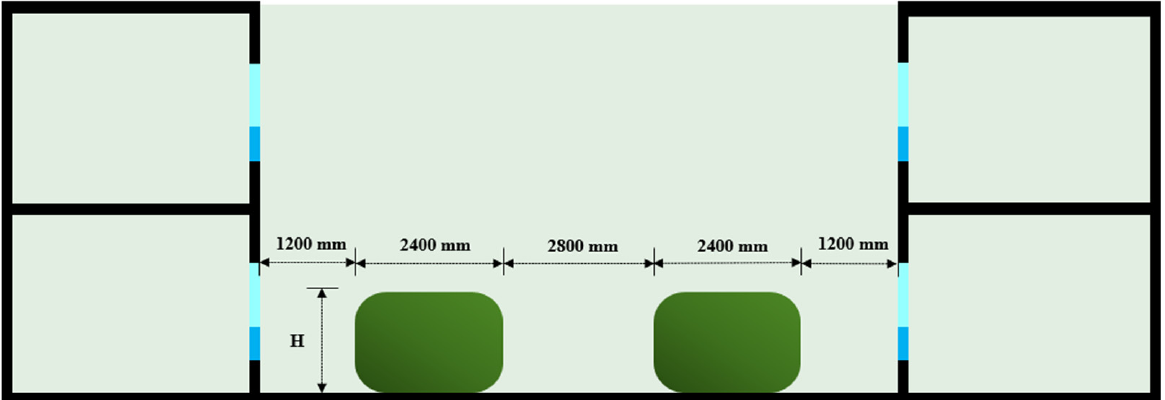
Figure 7. The dimension of the vegetation inside the courtyard model.